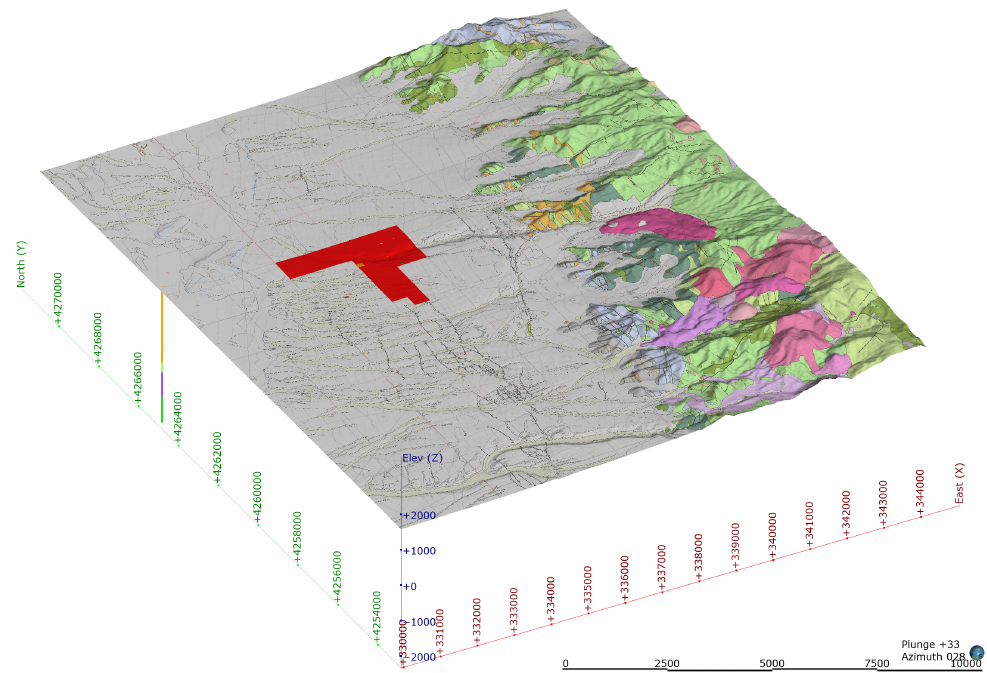
Figure 2. Location map of the Utah FORGE site (red highlighted area) earth model domain, with an oblique view showing the topography and the updated geologic map. Scalebar at bottom right is 10 km, with axes units in UTM (meters), Zone 12N, NAD83, and NAVD88. Major geologic units shown are green colors for undifferentiated granite, reddish/purple for rhyolite, and gray for alluvial sediments. Geologic map data adapted from